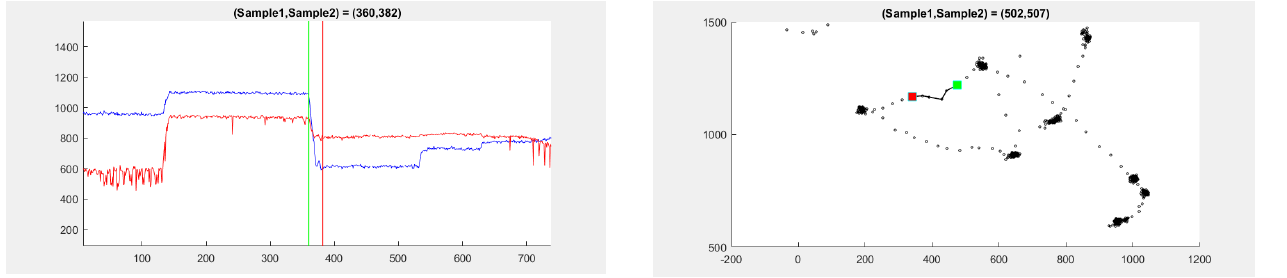
Figure 14 . Position plot for dataset 1.3 between sample 360 (green line) and sample 382 (red line) showing a complex transit between two fixations.